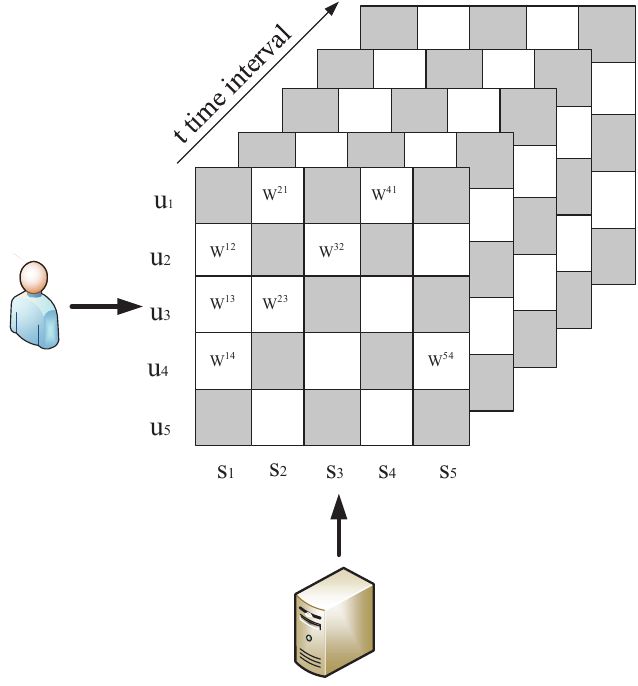
Figure 1. Quality of service (QoS)